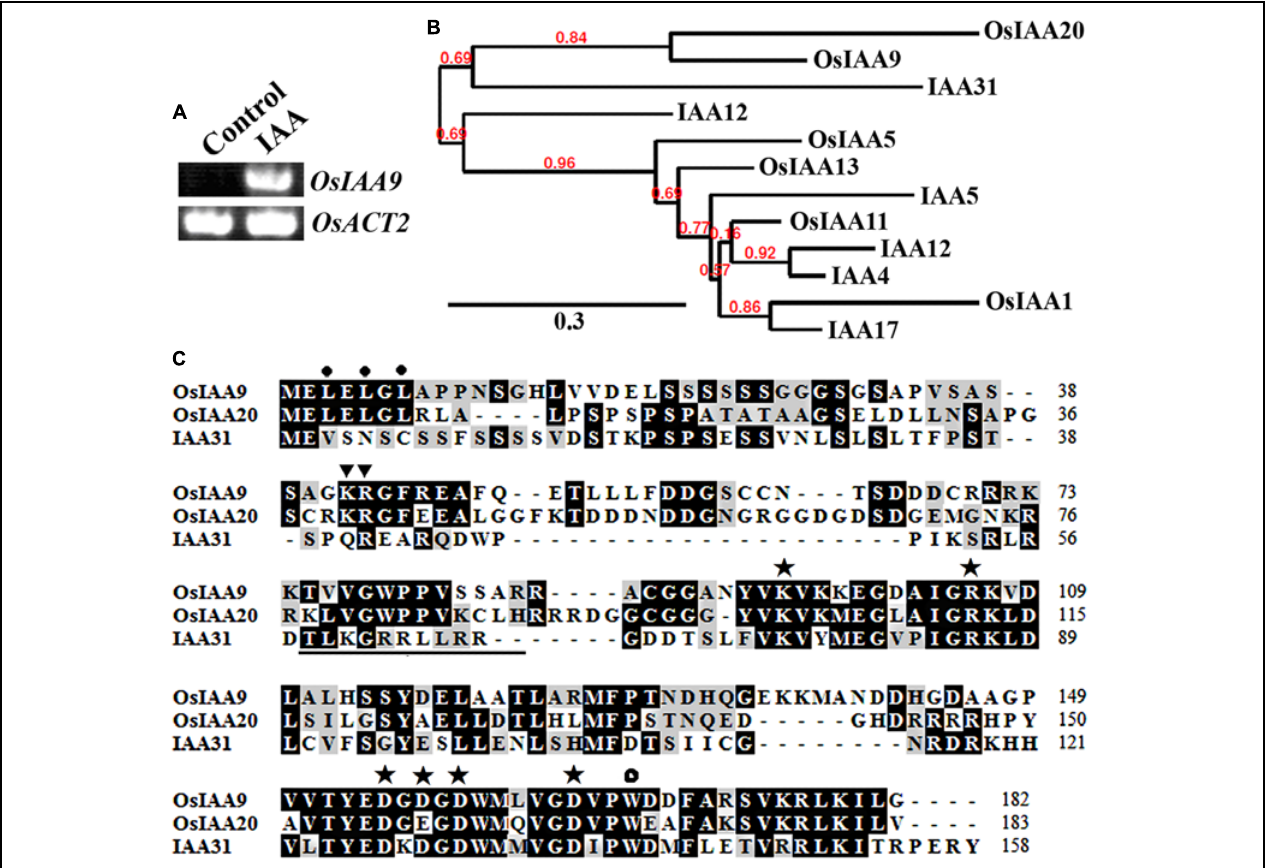
FIGURE 1 | OsIAA9 is a canonical Aux/IAA protein. (A) Expression of OsIAA9 in rice seedlings in response to IAA treatment. RNA was isolated from IAA treated rice seedlings and RT-PCR was used to examine the expression of OsIAA9 . Expression of OsACT2 was used as a control. (B) Phylogenetic analysis of OsIAA9 and some Arabidopsis and rice Aux/IAA proteins that have relative higher amino acid similarities with OsIAA9. The entire amino acid sequences were used to generate phylogenetic tree on Phylogeny (http://www . phylogeny . fr) by using the “One Click” mode with default settings. Branch support values are indicated above the branches. (C) Amino acid sequence alignment of OsIAA9, OsIAA20 and IAA31. Domain II is underlined. The KR residues between Domain I and II that are crucial for protein degradation are indicated by triangles, the L residues in the LxLxL repression motif are indicated by closed circles, the conserved residues in Domain III and IV that are crucial for protein–protein interaction are indicated by asterisks, and the conserved W residue in OsIAA23 that is crucial for protein–protein interaction is indicated by open